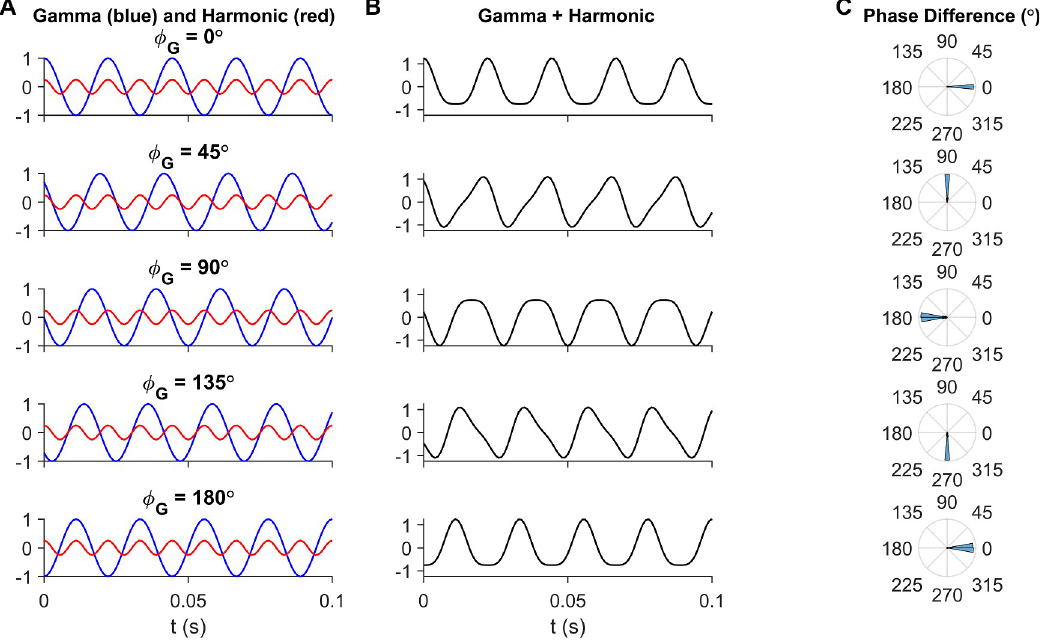
Fig 4. Observed arch-shape of gamma corresponds to gamma-harmonic phase difference of 180˚. (A) Gamma (blue) and harmonic (red) components, mimicked using sinusoids as in Eq (2) with different initial gamma phases ( φ G ) in each row. (B) Gamma waveform resulting from summation of gamma and its harmonic from the corresponding row in (B). (C) Phase difference of gamma and its first harmonic, as given in Eq (1), computed from filtering and Hilbert transforming gamma and harmonic bands from the summed waveform in (B) in each row. Note that the arch-shaped gamma observed in recordings arises from a phase difference of 180˚ (middle row).